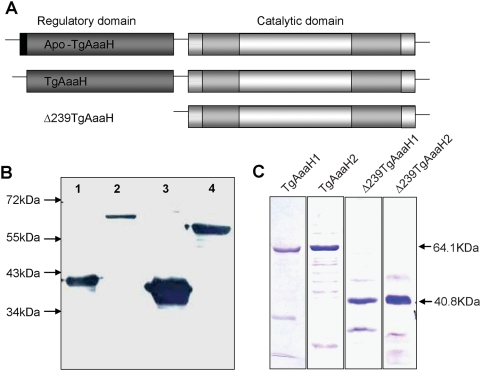

T. gondii aromatic amino acid hydroxylases expressed in this study.A Schematic representation of three forms of TgAaaH 1&2 expressed in this study. Apo-TgAaaH 1&2 encode the full length wildtype protein expressed in preliminary trials as a 6×His-recombinant protein of 601 amino acids (a.a.) and 66.5 kilodaltons (kDa), with the predicted signal peptide shown in black. As this protein was found to be extremely insoluble, the N-terminal 23 codons containing the predicted signal peptide was removed generating constructs named TgAaaH 1&2. The resulting proteins expressed are 578 a.a. and 64.1 kDa. Δ239TgAaaH 1&2 have the N-terminal 239 a.a. deleted resulting in expression of proteins of 361 a.a. and 40.8 kDa. B Western blot of proteins expressed from Δ239TgAaaH2 and TgAaaH2 and the recombinant rat protein controls probed with anti-rat tyrosine hydroxylase. Lane 1, Δ239TgAaaH2, lane 2 TgAaaH2, lane 3 rat-Δ117PheH and lane 4 rat-WT-TyrH. Due to the high degree of similarity with the rat enzyme, recombinant Toxoplasma proteins are recognized by antibody raised against the conserved domain of the rat tyrosine hydroxylase enzyme. C Coomasie stained SDS-PAGE gels of purified, recombinant proteins encoded by TgAaaH1, TgAaaH2, Δ239TgAaaH1 and Δ239TgAaaH2.